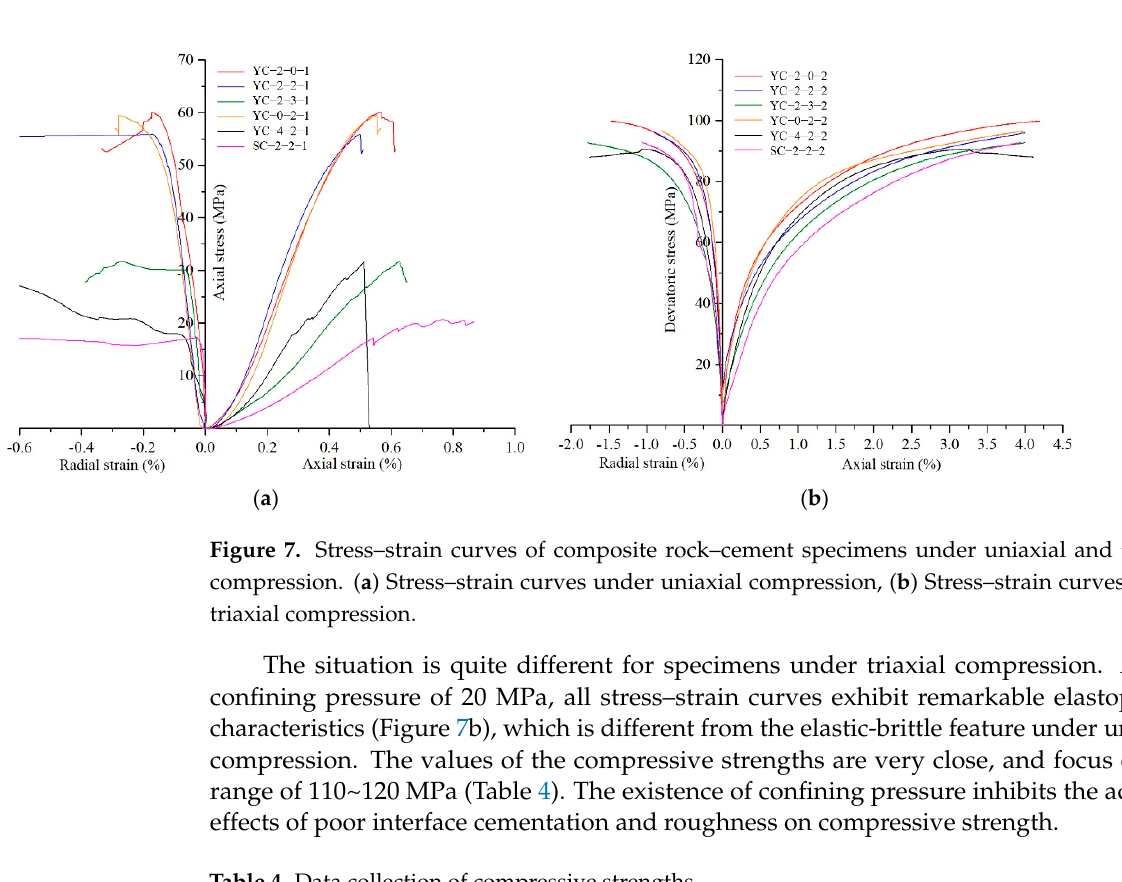
Table 4. Data collection of compressive strengths.